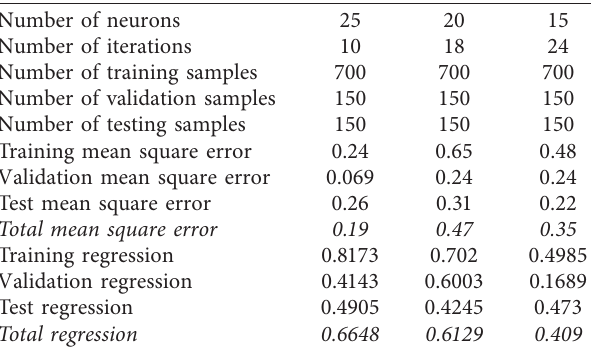
Figure 10: ANN training results for Stanford arm with assuming 15, 20, and 25 neurons in the hidden layer. Table 5: Neural network training results for RRR arm. Table 7: Neural network training results for Stanford